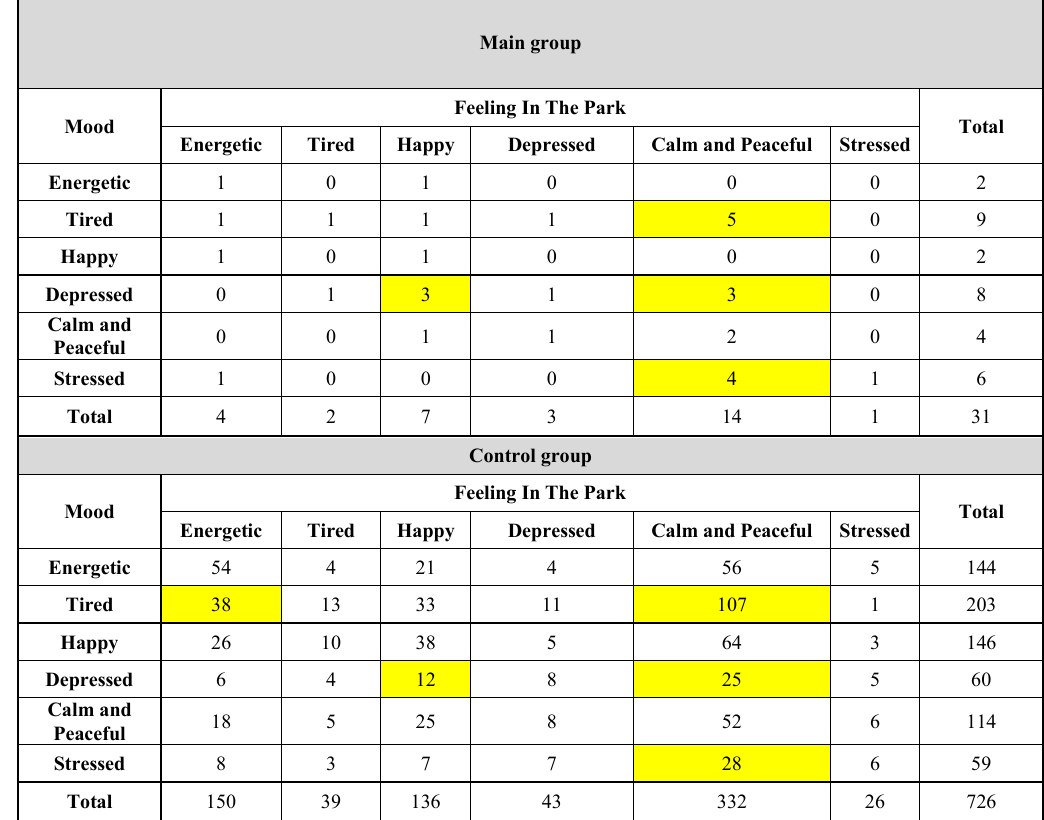
Table 2: Cross-Table in Main Group and Control Group for Current Feelings and Feelings in the Park